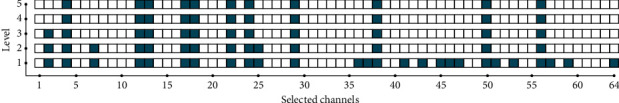
Distribution of selected channels with different levels of PSO for channel selection.